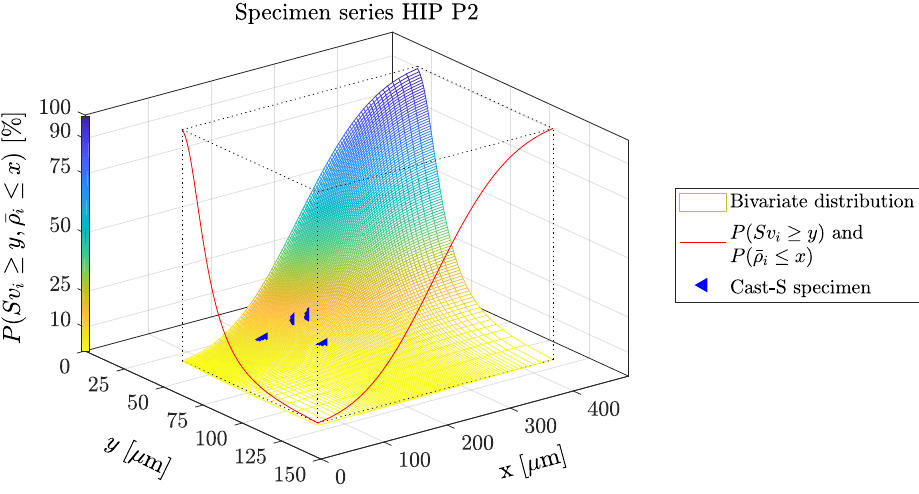
Figure A3. HIP P2 bivariate distribution of Sv i GEV distribution and ρ